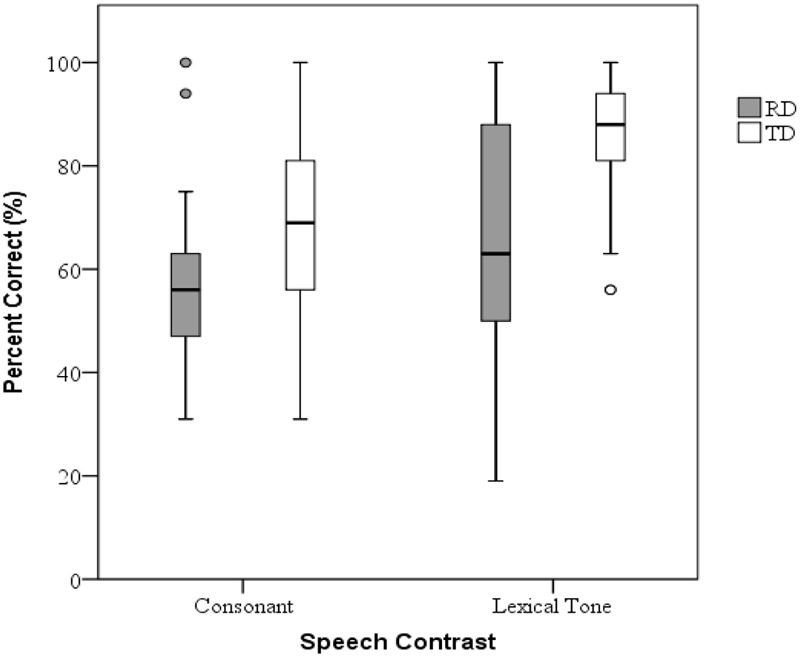
Percent corrects of speech discrimination in two groups.